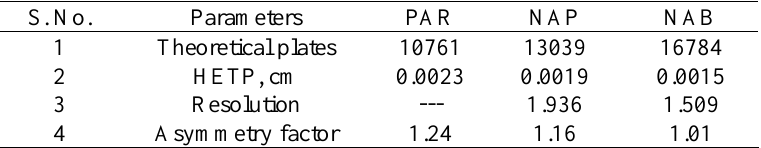
Table 1. System suitability parameters for RP-HPLC method S. No.